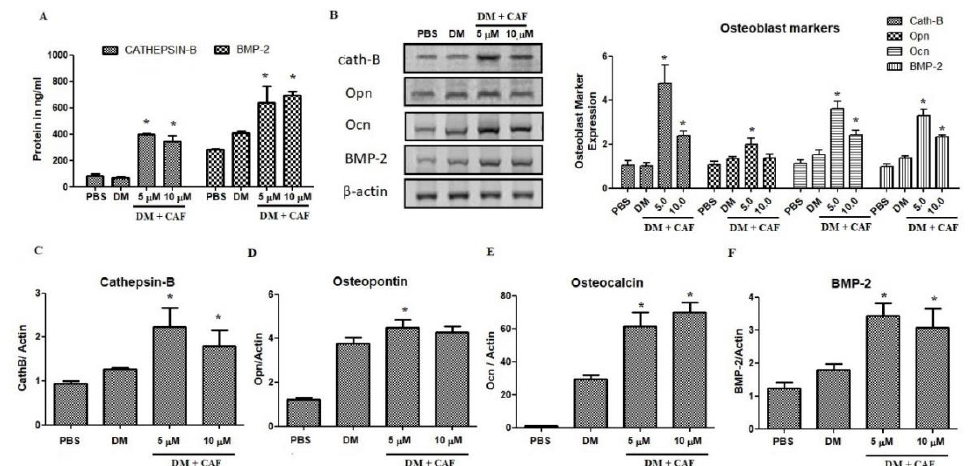
Figure 4. Effect of CAF on bone markers in osteoblast cell organization. ( A ) Cytokines estimation at 7th day of CAF treated osteoblastic cells. TNF-α and IL-10 were estimation using ELISA kits. ( B ) Effect of CAF on the protein expression of bone markers such as cathepsin-B (Cath-B), osteopontin (Opn), steocalcin (Ocn) and Bone morphogenic protein-2 (BMP-2). Protein expression were measured by Western blot analysis. ( C – F ) mRNA expression of bone markers on CAF treated osteoblastic cells and it was quantified by quantitative real time PCR was normalized to β-actin. ( C ) mRNA expression of cathepsin B, ( D ) mRNA expression of osteopontin, ( E ) mRNA expression of osteocalcin and ( F ) mRNA expression of BMP-2 marker, respectively. Bars represent the mean ± SD ( n = 4). Statistical results are shown as * p < 0.05.